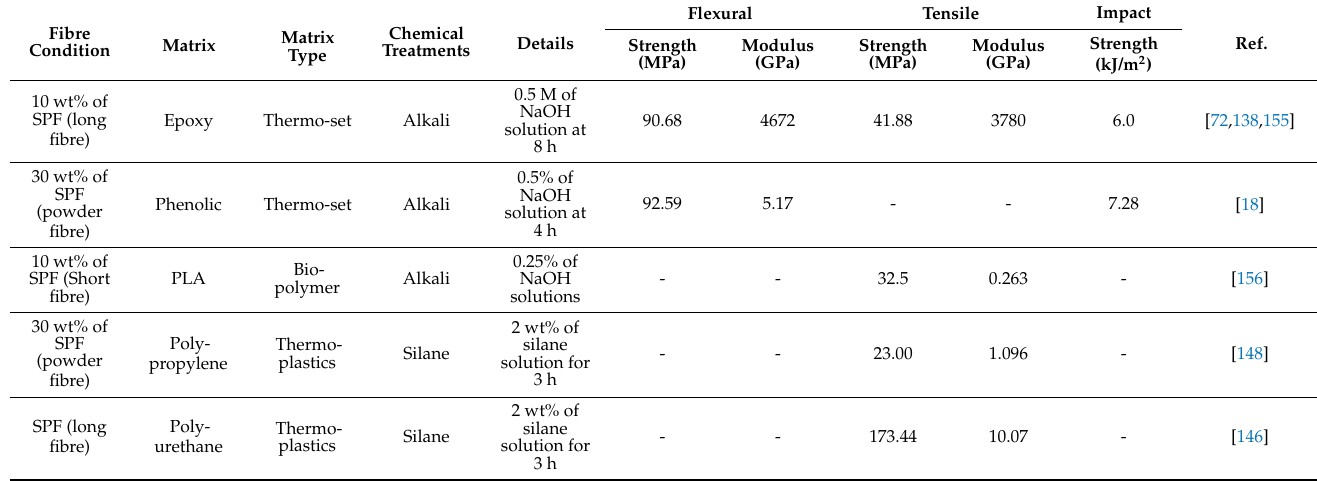
Table 6. Reported works on the mechanical properties of SPF-reinforced polymer